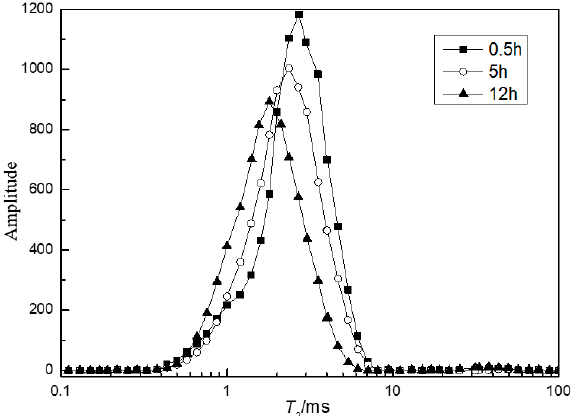
Figure 5. T 2 distribution of cement slurry with DMC content of 20%.